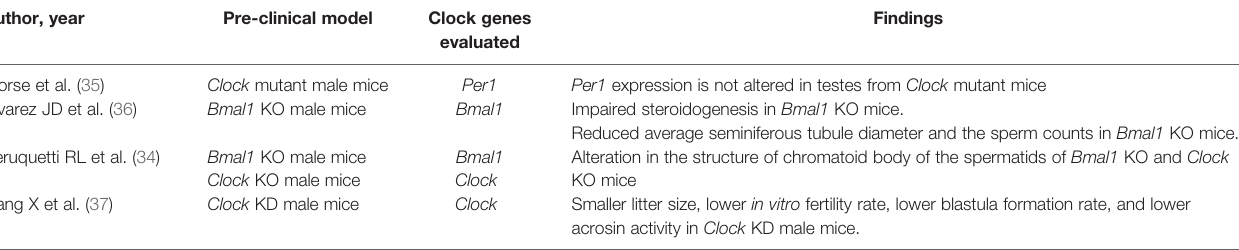
TABLE 1 | Findings from pre-clinical studies investigating the role of clock genes on